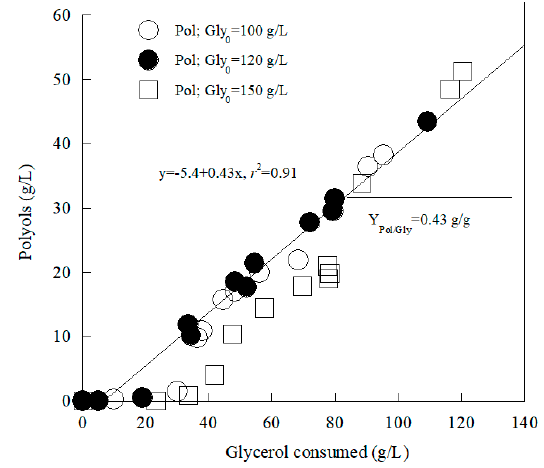
Figure 2. Total polyols ( Pol , g/L) produced vs. glycerol consumed (g/L) in shake-flask experiments during growth on pure glycerol by Yarrowia lipolytica LMBF Y-46, at elevated initial glycerol concentrations ( Gly 0 ≈ 100, 120 and 150 g/L) under nitrogen-limited conditions. Culture conditions: growth on 250 mL conical flasks at 180 ± 5 rpm, initial pH = 6.0 ± 0.1, pH ranging between 4.5 and 6.1, incubation temperature T = 28 ± 1 °C. Each experimental point is the mean value of two independent determinations (SE ≤ 18%).